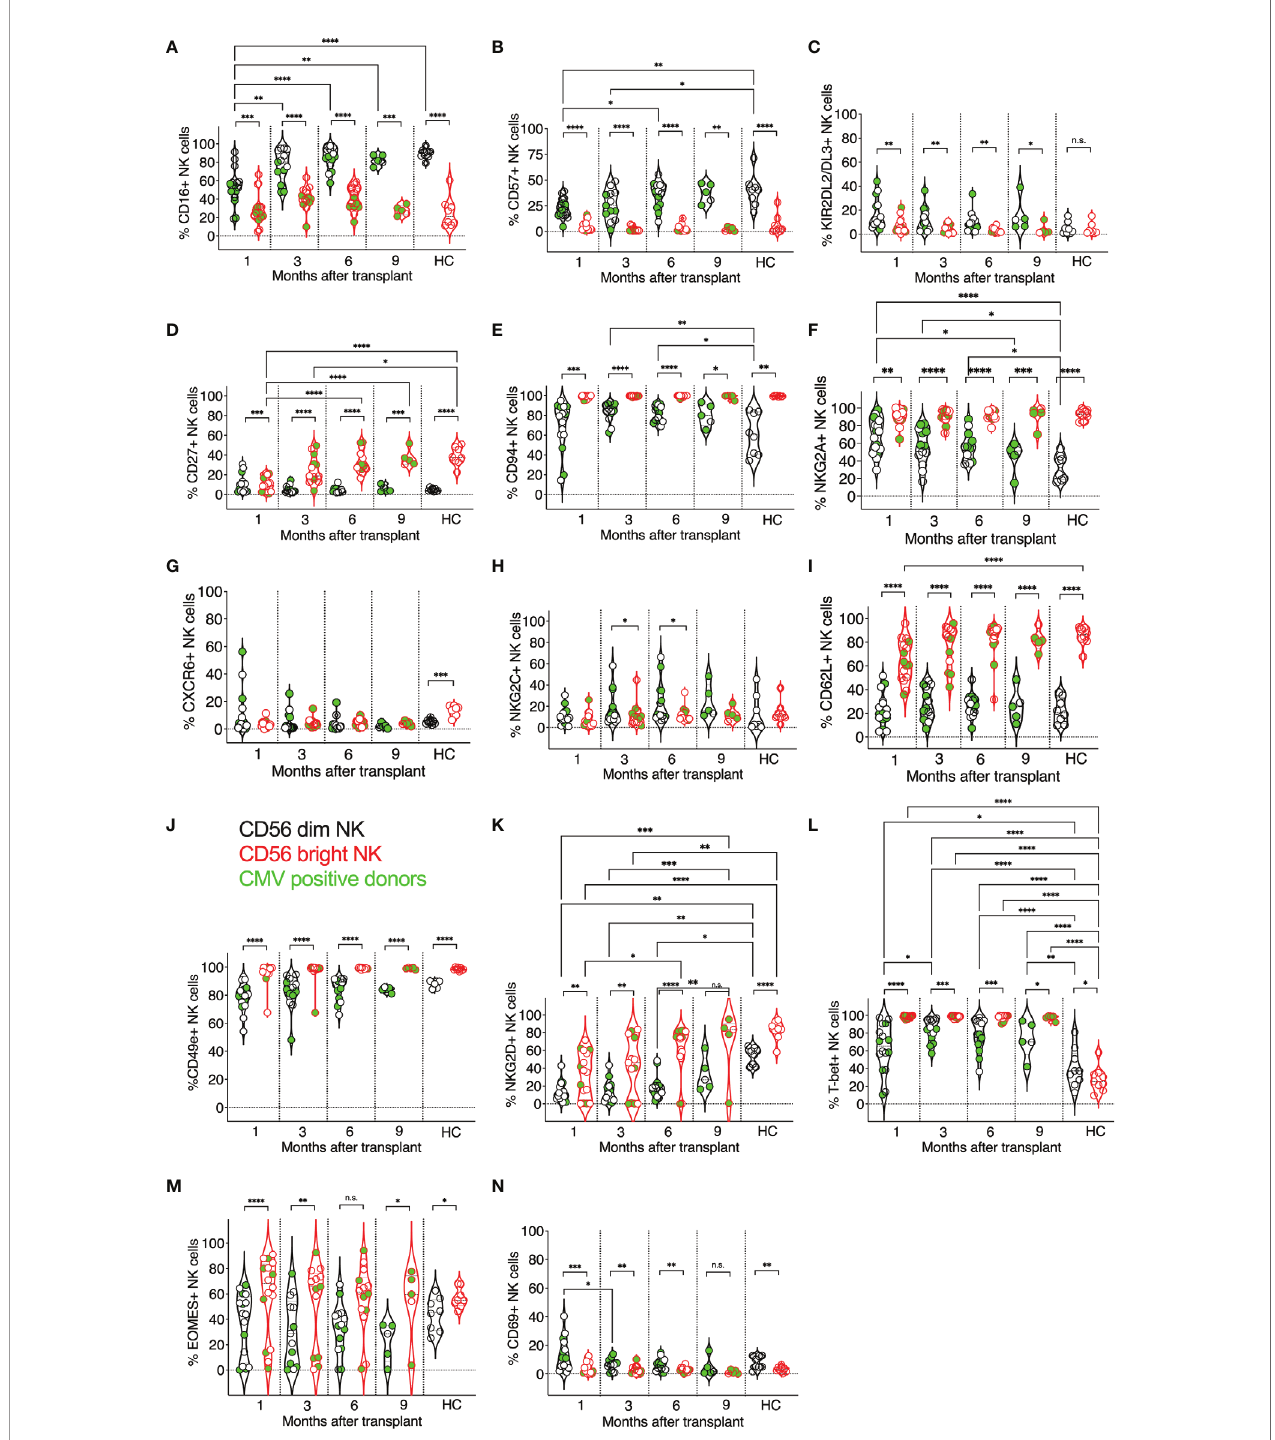
FIGURE 1 | Expression kinetics of developmental markers on CD56 dim and CD56 bright NK cells post-transplant. The frequencies of developmental markers (A – N) were determined for each patient ’ s circulating NK cells at indicated time points using multiparameter fl ow cytometry. Circulating healthy adult donor NK cells were also analyzed as a control. Each data point represents a single transplant recipient or healthy adult control donor (HC). Data points in black represent CD56 dim NK cells; data points in red represent CD56 bright NK cells. Data points with a neon-green fi ll color represent patients positive for CMV up to and at the analysis time as determined by quantitate PCR. *p < 0.05; **p < 0.005; ***p < 0.0005; ****p < 0.0005; Not signi fi cant